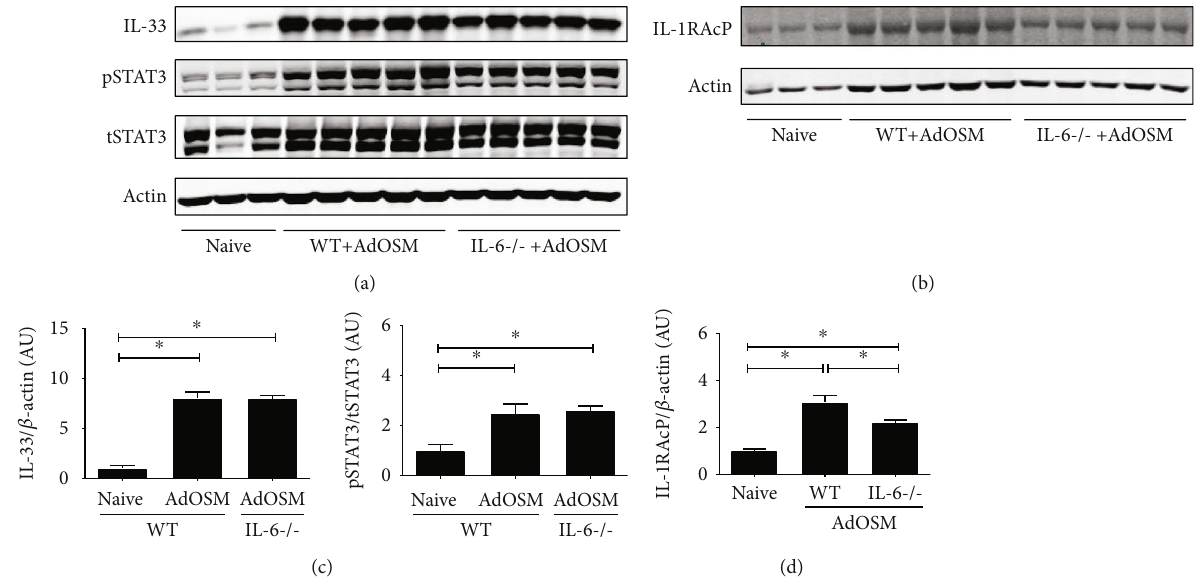
Figure 7: AdOSM-induced IL-33 expression is independent of IL-6. C57Bl/6 wild-type or IL6-/- mice were endotracheally administered AdOSM and whole lung cell lysates analyzed the expression of beta actin and (a) IL-33, phospho-STAT3/total STAT3 (pSTAT3/tSTAT3), or (b) IL-1 receptor accessory protein (IL-1RAcP), after 7 days by Western blotting. (c, d) Densitometry analysis of IL-33 and or